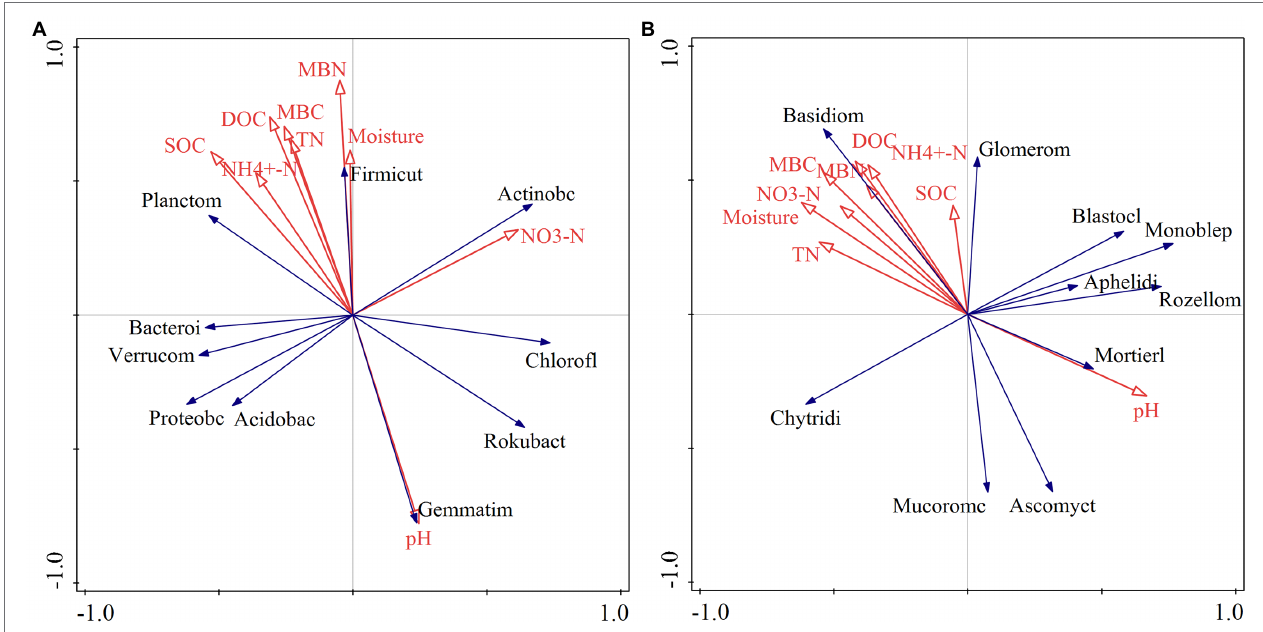
FIGURE 8 | Redundancy analysis of soil bacterial (A) and fungal (B) communities and soil physicochemical properties. pH: soil pH; NO 3 − -N: soil nitrate nitrogen; moisture: soil moisture content; MBN: soil microbial biomass nitrogen; MBC: soil microbial biomass carbon; TN: total nitrogen; DOC: soil dissolved organic carbon; NH 4+ -N: soil ammonium nitrogen; SOC: soil organic carbon; Proteobc: Proteobacteria; Acidobac: Acidobacteria; Actinobacteria: Actinobacteria; Chlorofl: Chloroflexi; Bacteroi: Bacteroidetes; Verrucom: Verrucomicrobia; Planctom: Planctomycetes; Gemmatim: Gemmatimonadetes; Rokubact: Rokubacteria; Firmicut: Firmicutes; Basidiom: Basidiomycota; Ascomycot: Ascomycota; Mortierll: Mortierellomycota; Chytridi: Chytridiomycota; Rozellom: Rollomycota; Monhelep: Monoblephelomycota; Mucoromc: Mucoromycota; Blastocl: Blastocladiomycota; Glomerom: Glomeromycota; Aphelidi: Aphelidiomycota.